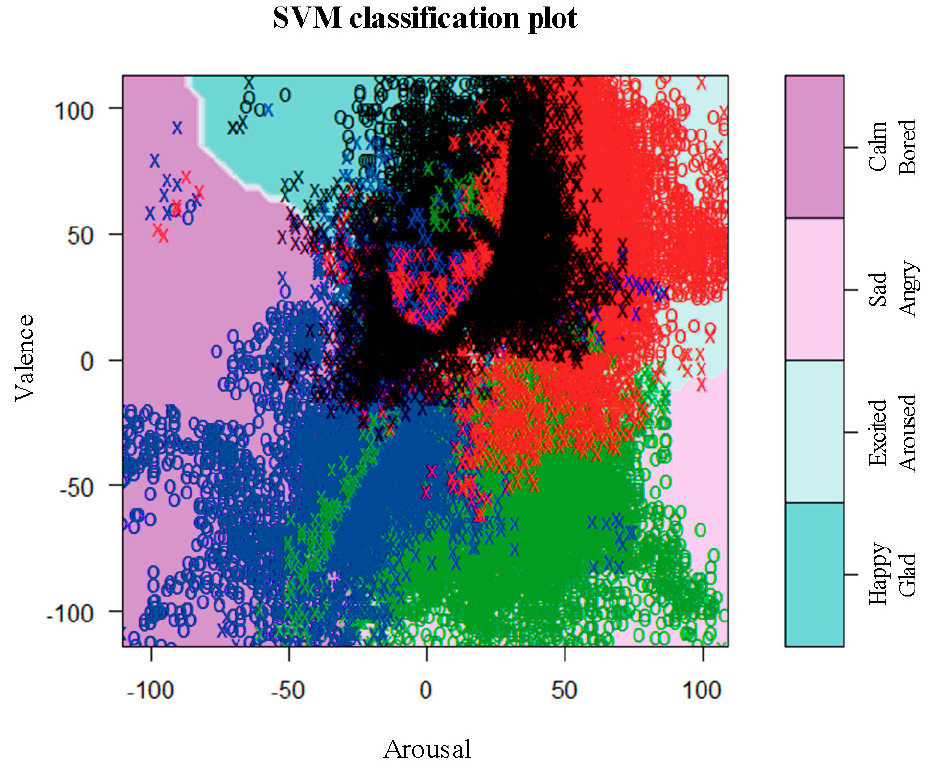
Figure 10. Emotion Classification F igure 10. Emotion Classification Map.